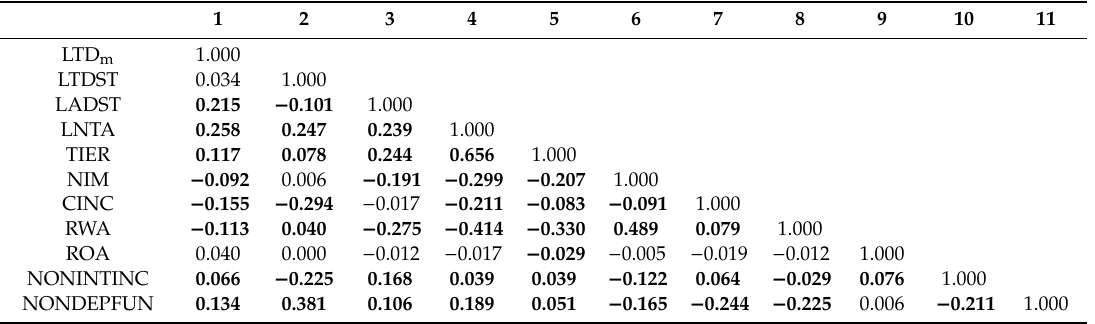
Table 2. Pearson correlation coe ffi